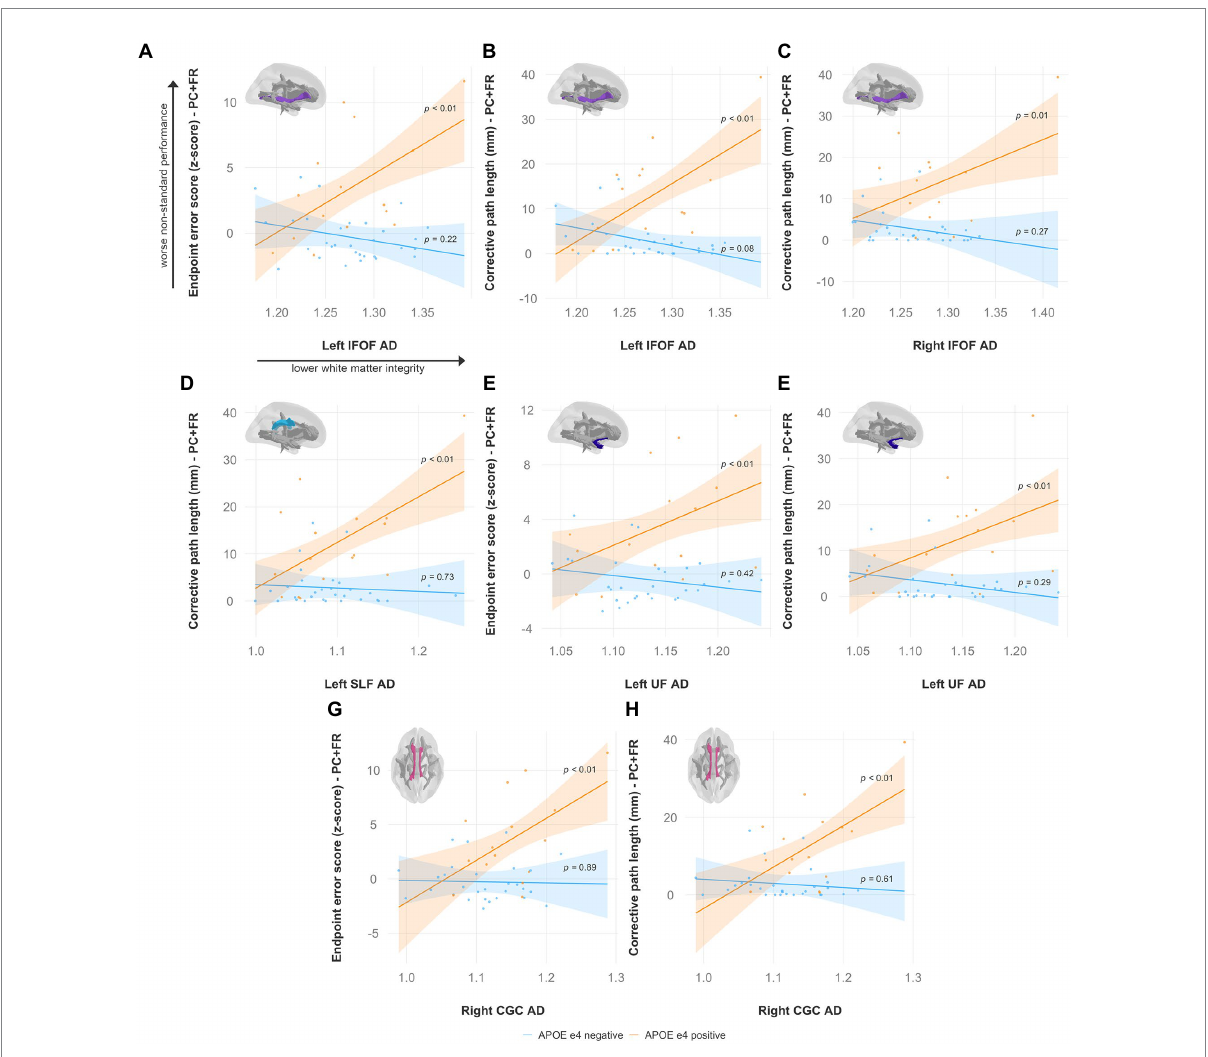
FIGURE 9 Higher axial diffusivity predicts worse visuomotor performance (reflected by higher endpoint error scores or corrective path lengths) in the plane- change feedback reversal condition only in APOE e4 carriers in several major white matter tracts, including the (A,B) left IFOF, (C) right IFOF, (D) left SLF, (E,F) left UF, and (G,H) right CGC. Significant results shown from multiple regression and simple slopes analyses. Brain figures made with “ggseg” R package (Mowinckel and Vidal-Piñeiro, 2020). PC + FR, plane change feedback reversal condition; APOE, apolipoprotein E; AxD, axial diffusivity; IFOF, inferior fronto-occipital fasciculus; SLF, superior longitudinal fasciculus; UF, uncinate fasciculus; CGC, cingulum